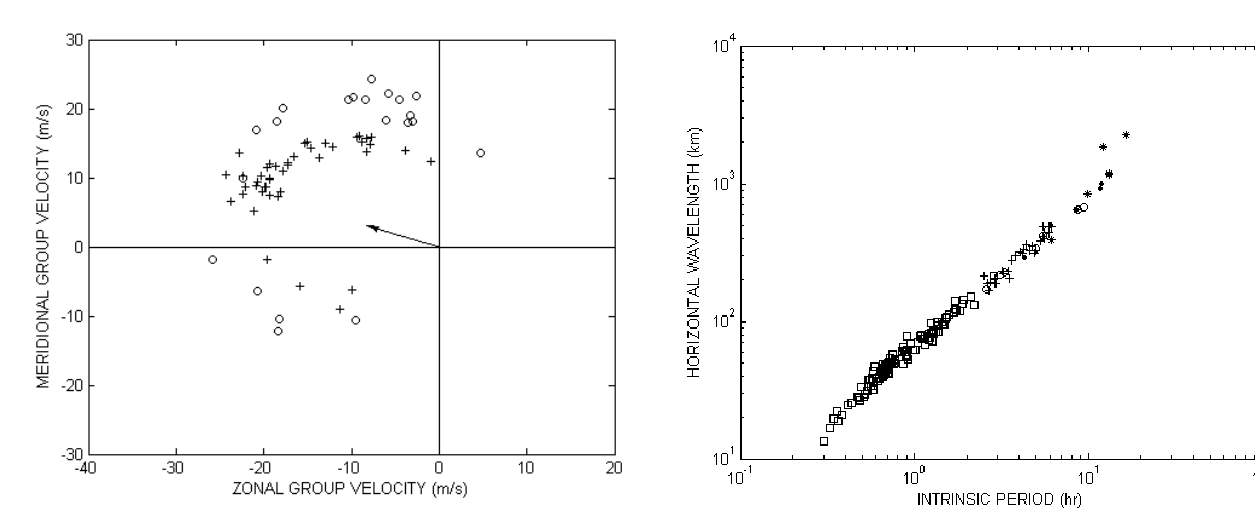
Fig.11 Horizontal wavelengths versus intrinsic periods of upward moving gravity Fig. 11. Horizontal wavelengths versus intrinsic periods of upward wave packets of winter data set. Wave packets obtained by window T2Z5 were moving gravity wave packets of winter data set. Wave packets ob- denoted by ‘square’ ; Wave packets obtained by window T3aZ5 were denoted tained by window T2Z5 were denoted by square; Wave packets ob- by ‘cross’; Wave packets obtained by window T3bZ5 were denoted by ‘open tained by window T3aZ5 were denoted by cross; Wave packets ob- circle’; Wave packets obtained by window T3cZ5 were denoted by ‘dot’; tained by window T3bZ5 were denoted by open circle; Wave pack- Wave packets obtained by window T4Z5 were denoted by ‘star’. ets obtained by window T3cZ5 were denoted by dot’; Wave packets obtained by window T4Z5 were denoted by